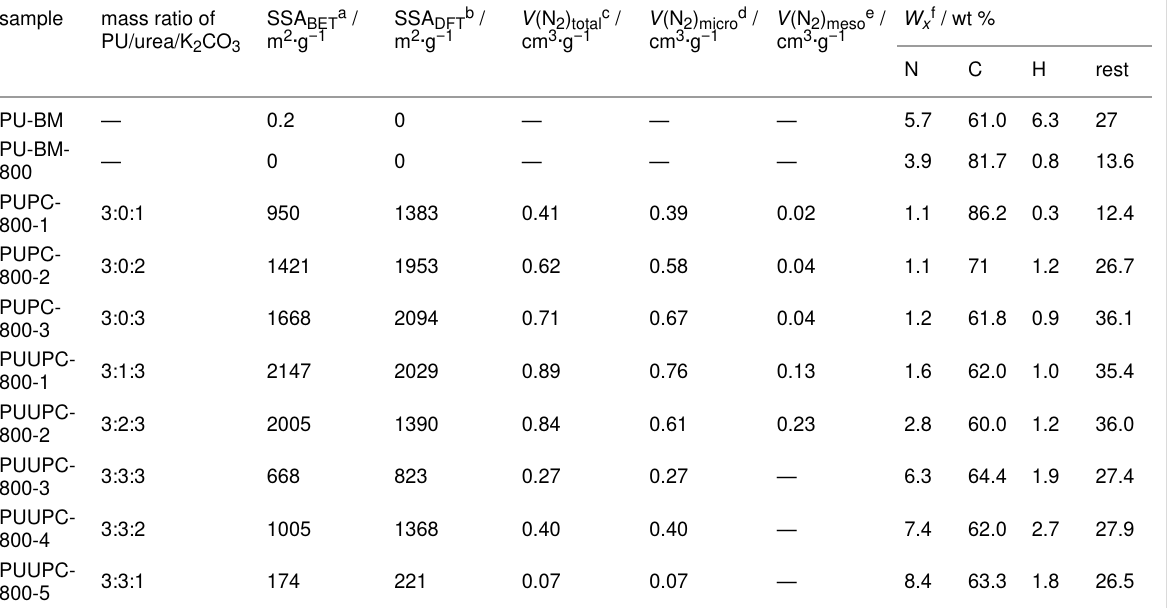
Table 1: Characterization data of different N-doped carbon samples after milling and carbonization. Physisorption data derived from N 2 isotherms measured at − 196 °C. Element concentrations derived from elemental analysis. sample